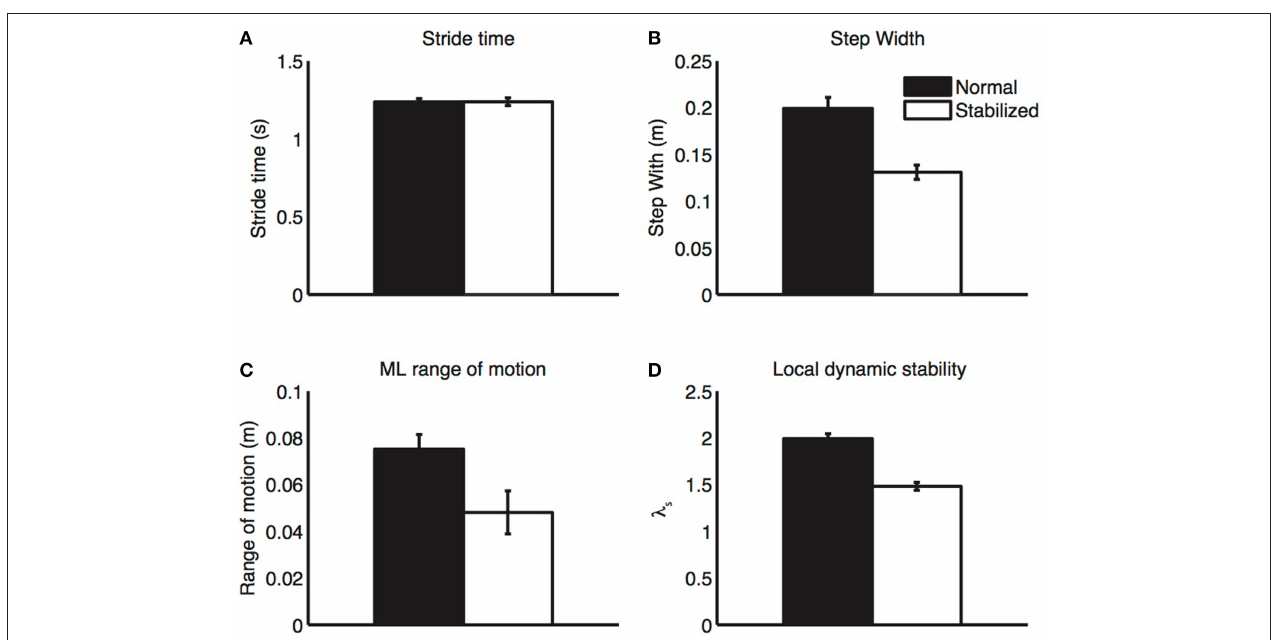
FIGURE 2 | Gait parameters. During stabilized walking, subjects walked with similar step length (A) , but had clearly reduced step width (B) , medio-lateral trunk excursion (C) , and local divergence exponents (D) , all indicative of increased stability. Bars represent mean values, error bars represent standard errors.